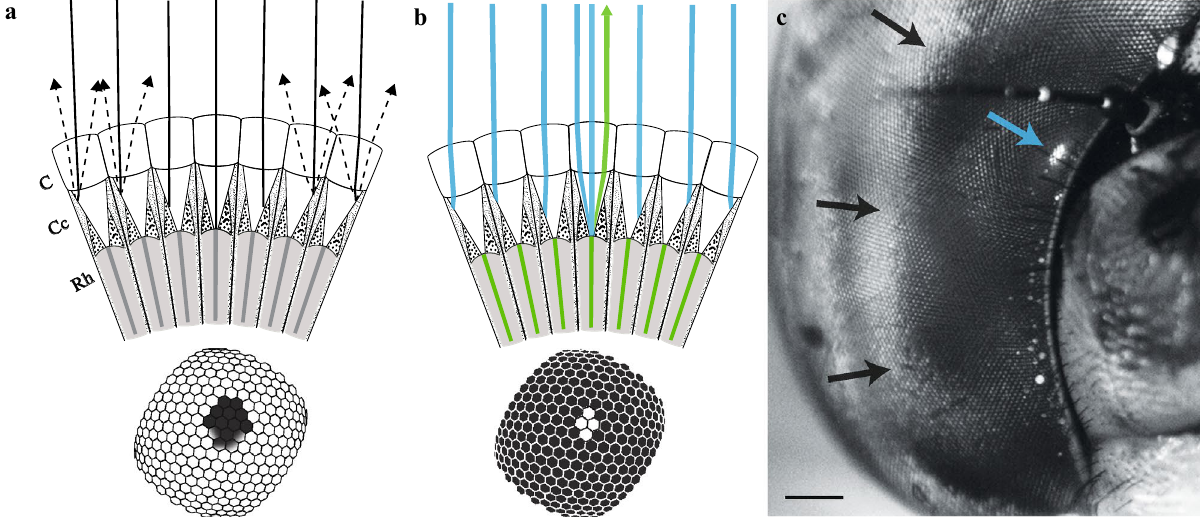
Figure 1. Dark and induced fluorescent pseudopupils. (a) Section of an insect apposition compound eye illustrating formation of the principal pseudopupil when illuminated by incident co-axial light ( continuous black lines ); modified after 22 . To the experimenter, looking through the lens of the microscope, the surface of the eye ( diagram below ) will appear pale in the majority of the facets where incident light is scattered from secondary pigment cells ( black dashed lines ). However, in ommatidia aligned with the viewing axis, light is absorbed by rhabdoms and primary pigment cells, making them appear dark ( diagram below ). C corneal facet, Cc crystalline cone, Rh rhabdom. (b) Section of an apposition compound eye illustrating formation of the fluorescent pseudopupil. In this case the compound eye has been injected with a fluorescent dye that has been taken up by the rhabdomeres ( green shade in the diagram, e.g. Lucifer Yellow or Neurobiotin 488, see “Methods” section and Fig. 2). Short wavelength incident light ( blue shade ) will excite the fluorophore in the rhabdomeres so that only those ommatidia aligned with the optical axis of the microscope will re-emit longer wavelengthlight ( green line ). These re-emitted light rays will cause the facet lenses through which they pass to be bright compared to the surrounding facet lenses which will be dark ( diagram below ). (c) Images taken from the eye of a dragonfly, Aeshna cyanea , whose induced fluorescent pseudopupil was obtained using Lucifer Yellow (see “Methods”). Scale bar: 500 µm. Images from Supplementary Information video 1, part 1. A. cyanea has a frontal acute zone that is very broad ( black arrows ) as seen by the dark pseudopupil occupying a large area of the frontal part of the eye when the animal is perpendicular to the axis of the objective, i.e. at 0° longitude. However, the induced fluorescent pseudopupil ( blue arrow ) is easily identified and because it is confined to a smaller region of the eye, its centre is easy to fluorescent pseudopupil, application of the combination of dimethylsulfoxide (DMSO), ringer solution and a fluorescent neuronal tracer (either Neurobiotin 488 or Lucifer Yellow) appears to retrogradely label the photore-